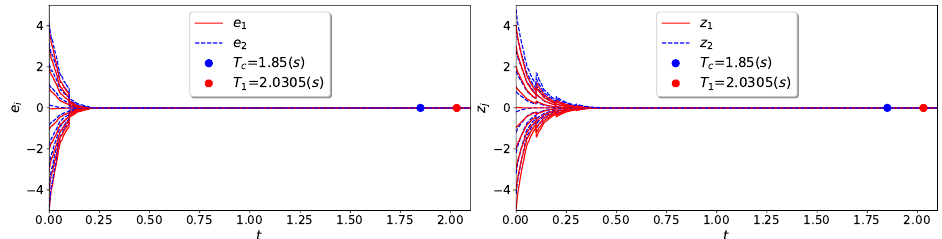
Figure 3. Evaluation of synchronization errors for Example